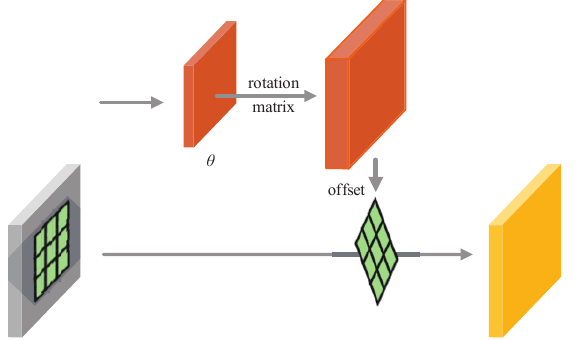
Figure 7. The overall process of AdaptConv. Decoded angle feature map θ is used to generate the offset. The special offset causes the DCN to have a receptive field with regular shape and angle